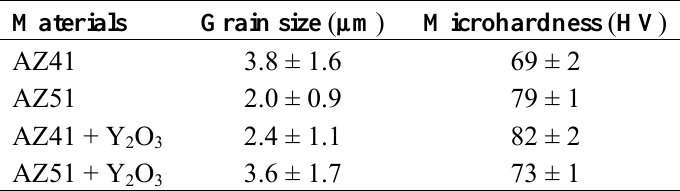
Table 1. Results of grain size and